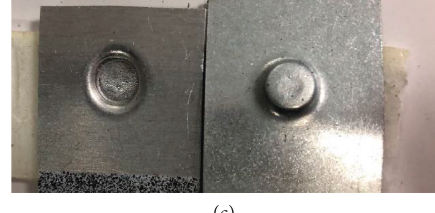
Figure 3: Static lap shear tests: (a) force-displacement curves, (b) material fracture failure mode of the SPR joint, and (c) pulling-out failure mode of the clinched joint at 0.083 × 10 − 3